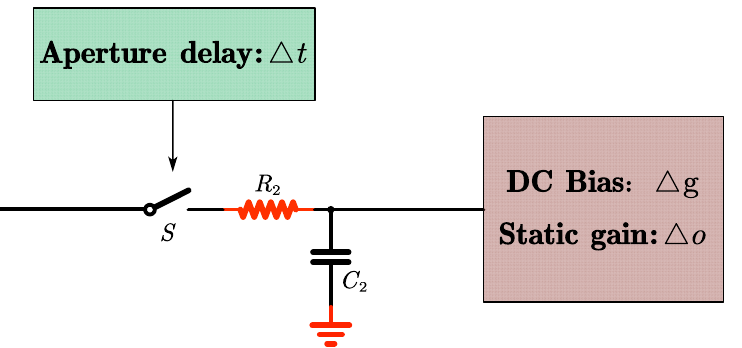
Figure 5. Equivalent model of a single sub-channel ADC in a TIADC system with channel mismatch. According to the relationship between system frequency characteristics and the